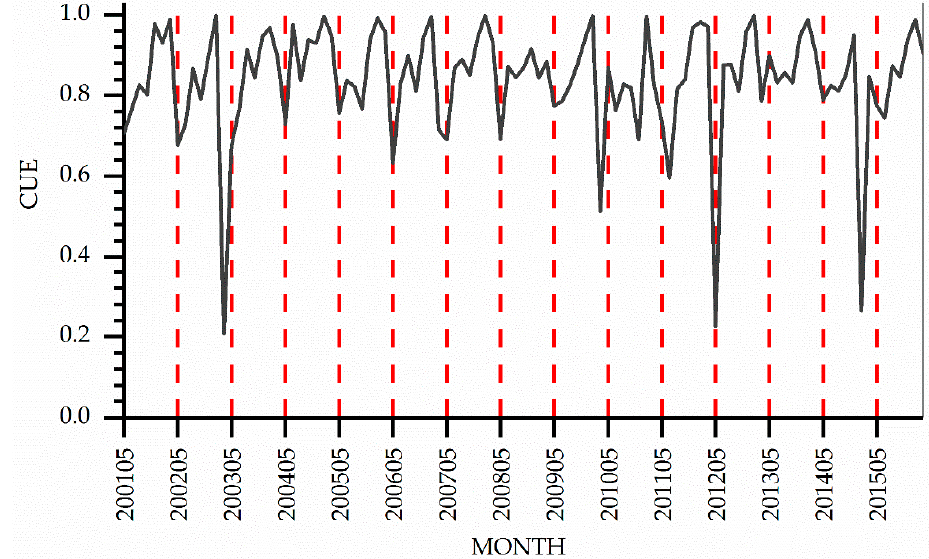
Figure 3. Regional average CUE at the monthly scale from 2001 to 2015.